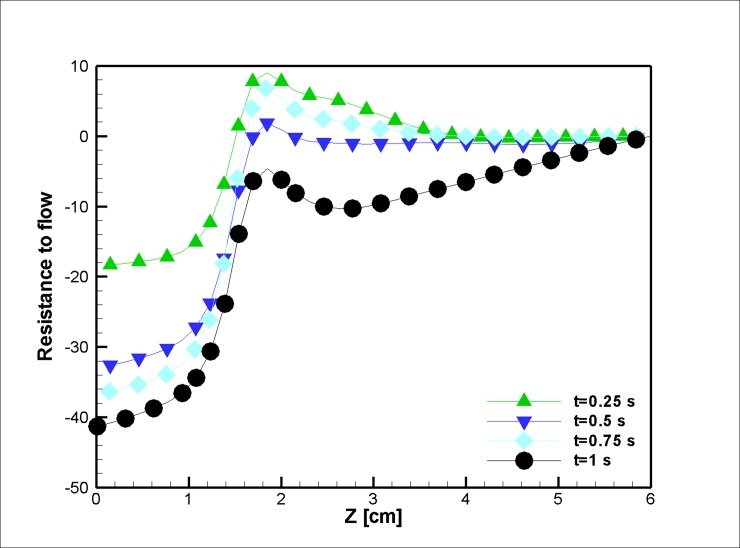
Variation in the resistance to the flow along the midline of stenosis (r = 2.5 mm) for different time instances in the case without joule heating.(Lvessel
= 6 cm, Rvessel
= 1 cm, 50 percent stenosis).